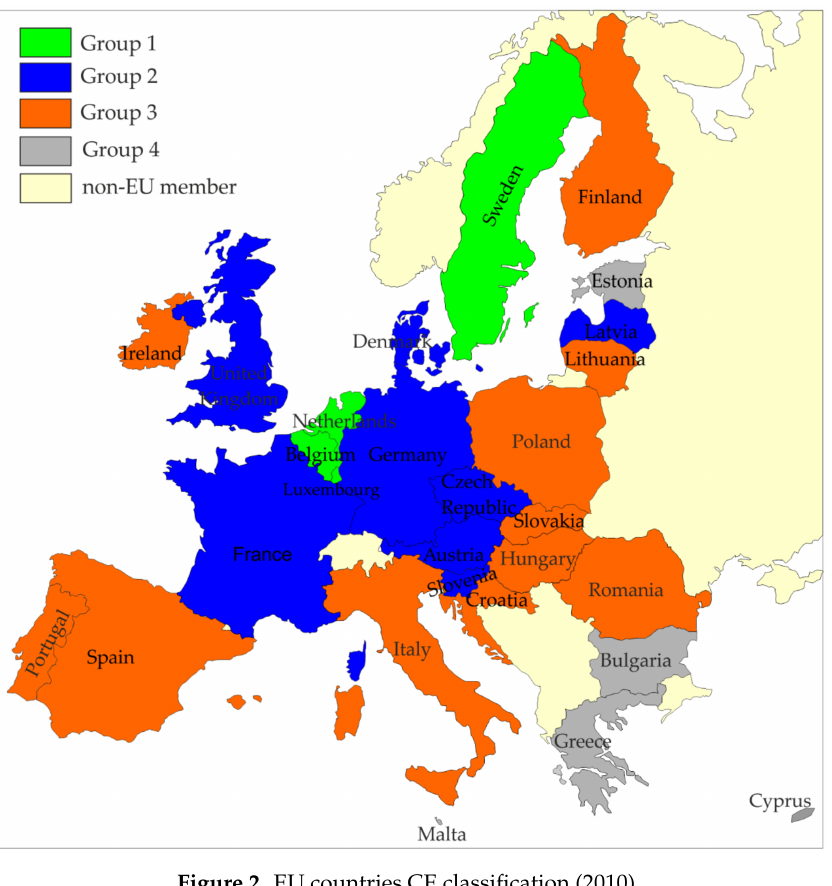
Figure 2. EU countries CE classification (2010).